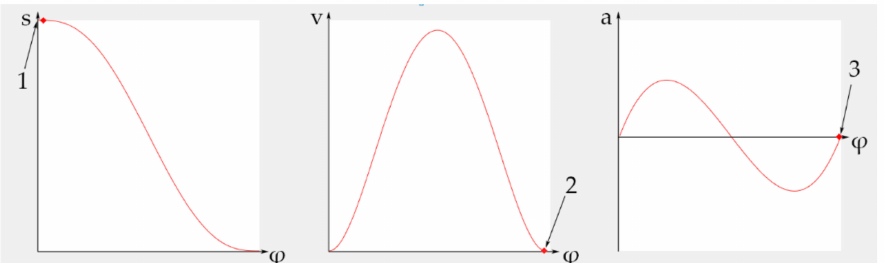
Figure 8. The displacement, velocity, and acceleration curves of the follower when the cam is working in the return zone. (1) The descending height h of the follower in the return zone (2). The movement speed of the follower at the end of the return zone (3). The movement acceleration of the follower at the end of the return zone.